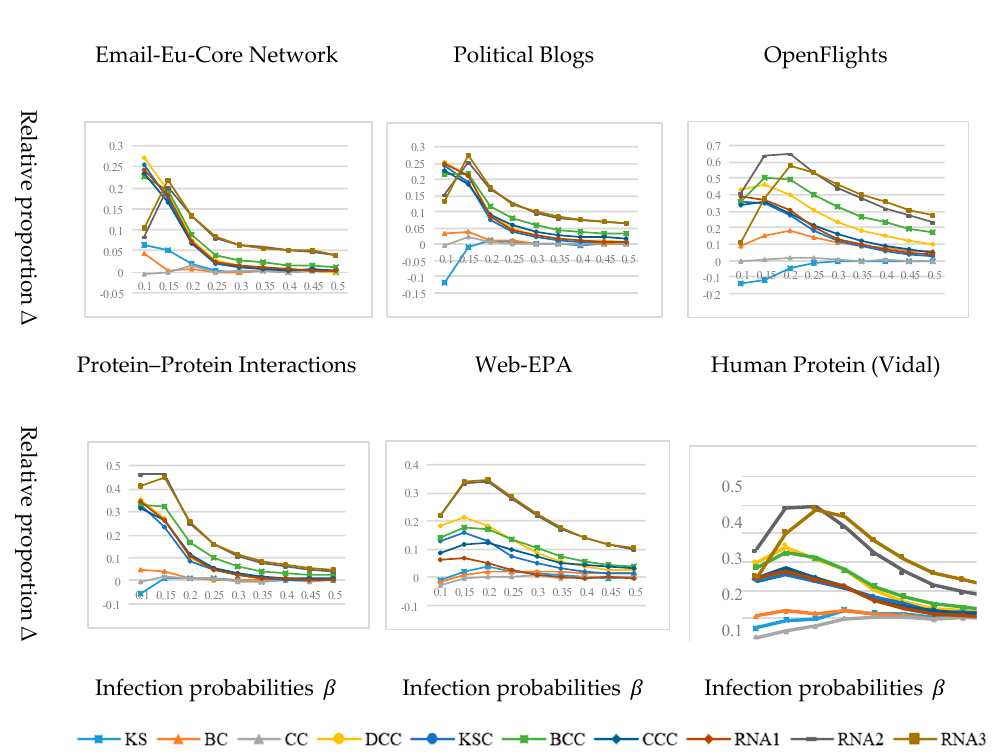
Figure 2. In the single-point contact susceptible-infectious-recovered (SIR) model, the relationship between Δ and 𝛽 with 1% nodes in the key node set.